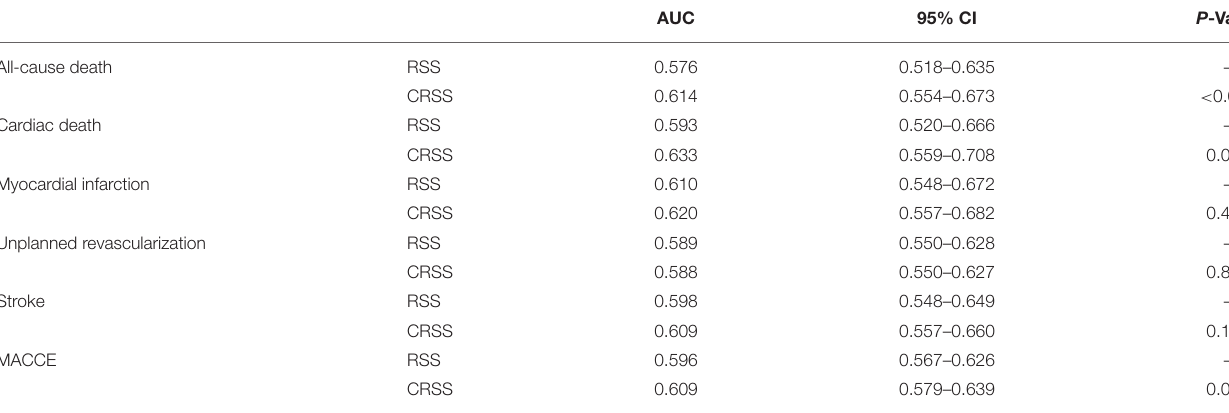
TABLE 5 | Comparison of ROC curves between RSS and CRSS.